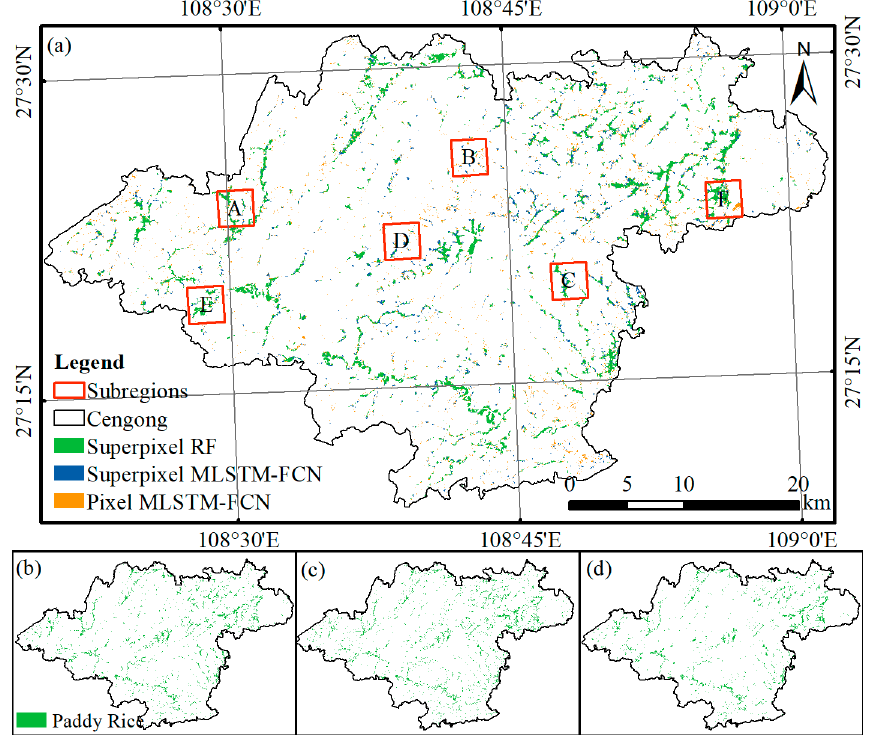
Figure 8. Paddy rice mapping results for 2020. ( a ) Stack of paddy rice maps generated by superpixel MLSTM-FCN (green), superpixel RF (yellow), and pixel MLSTM-FCN (blue). ( b – d ) represent the paddy rice mapping result using ( b ) superpixel MLSTM-FCN, and ( c ) pixel MLSTM-FCN, ( d ) superpixel RF. The red square represents six subregions (subregion A to subregion F) that were used to compare the detailed information created by classifiers.